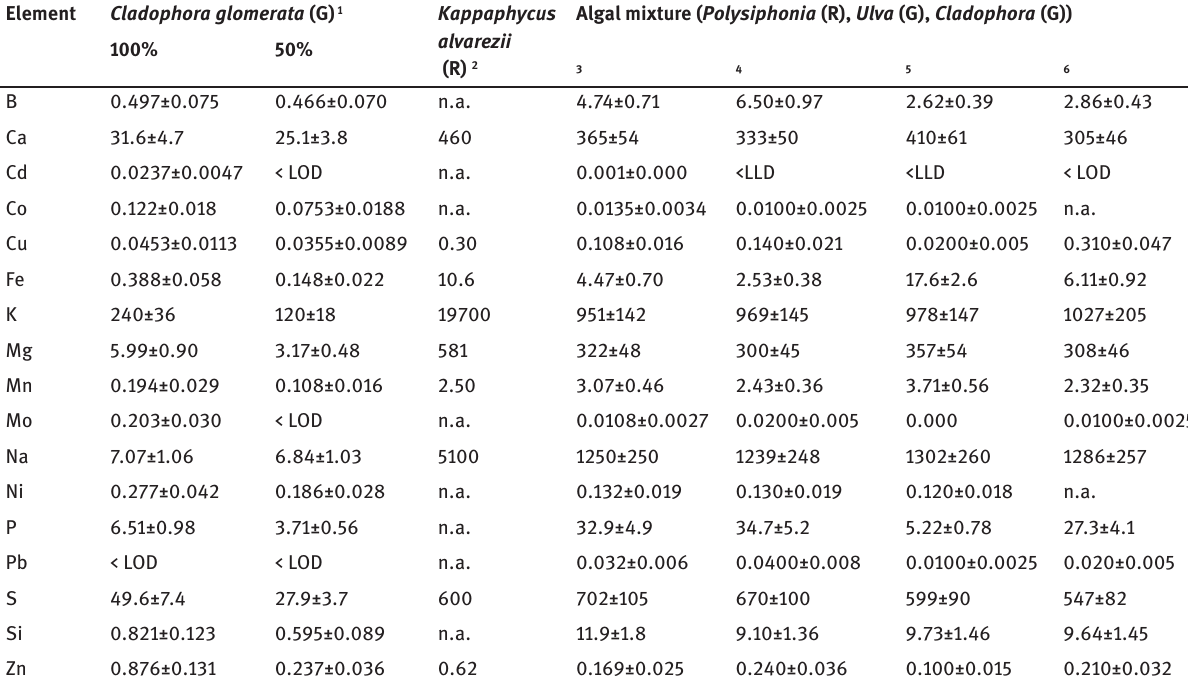
Table 1: Multielemental composition (mg/L) of aqueous macroalgal extracts. Element Cladophora glomerata (G) 1